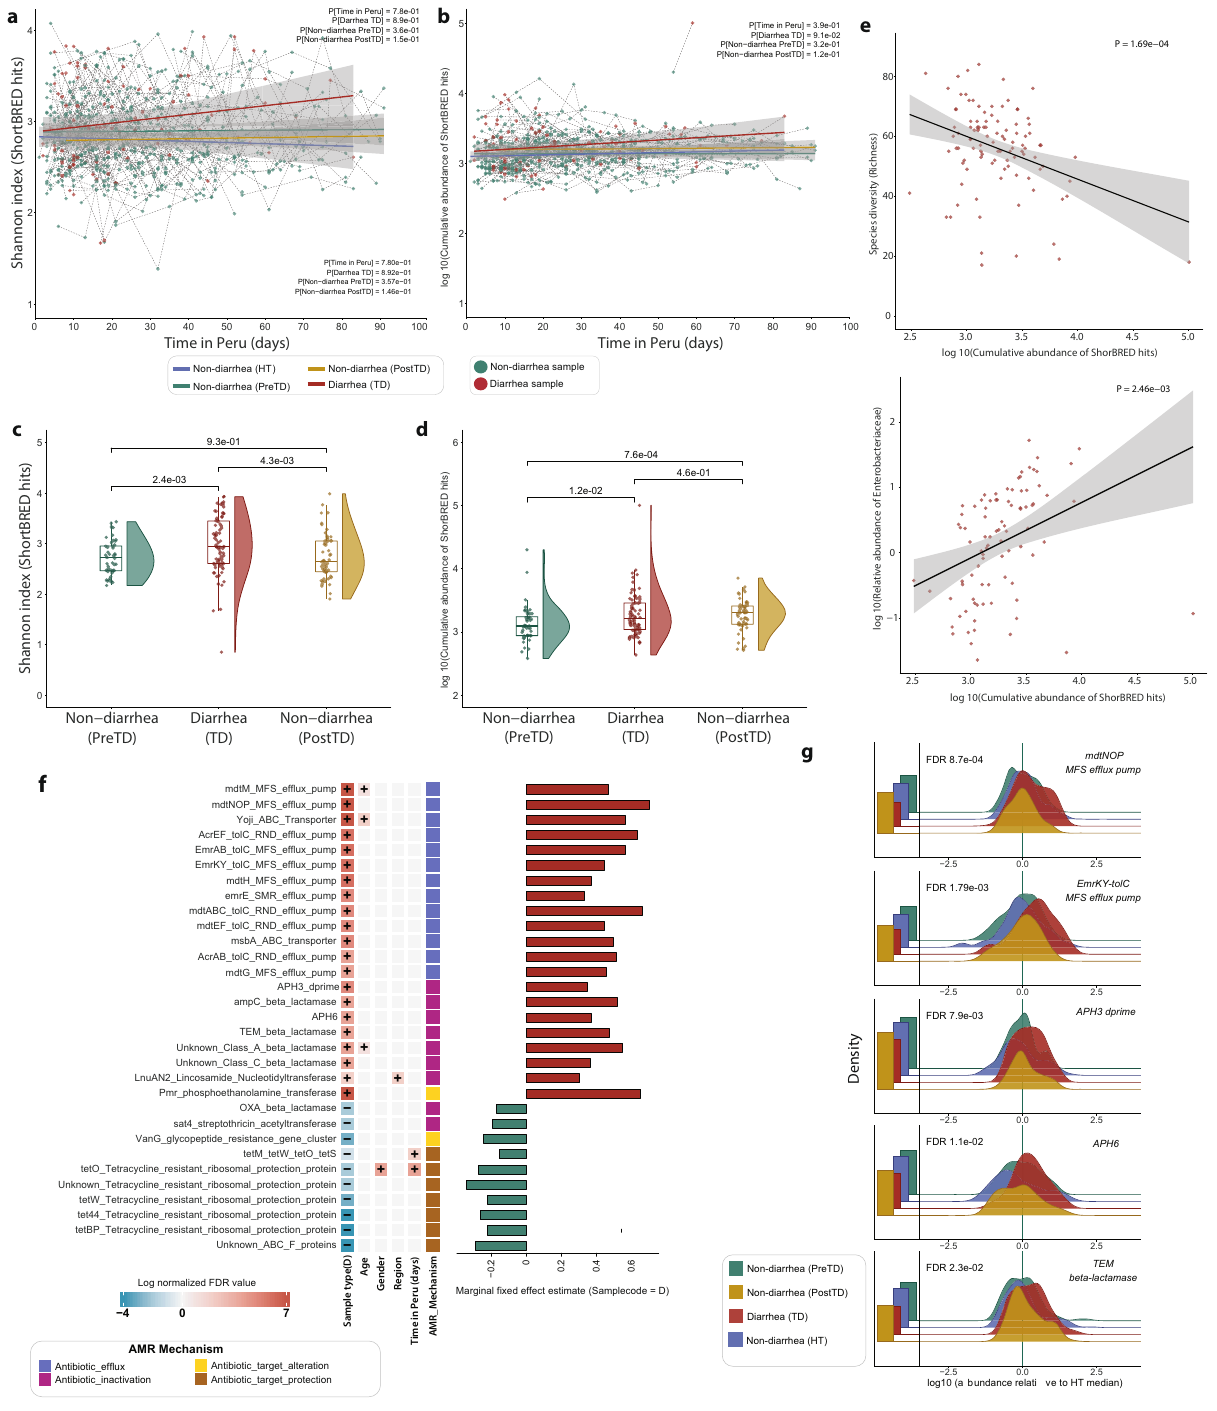
clusters were independently con fi rmed using BAPS 51 . Our DEC isolates P <0.05). These isolates were signi fi cantly enriched for bla TEM-148 , sul2 , grouped into 6 distinct clusters corresponding to phylogroups A, B1, B2, D, E, and F. The majority belonged to Clade A (106/189; 56.1%) and Clade B1 (56/189; 29.6%). No signi fi cant association between phy- logroups and sample type (diarrheal vs. non-diarrheal) was observed (Fishers exact test, P >0.05), except for isolates belonging to Clade B2 and Clade F that were isolated only from non-diarrheal samples. DEC strains isolated from non-diarrheal samples in TD subjects encoded more ARGs than isolates from HT subjects (Fig. 6a; Supple- mentaryFig. 7a,b) (non-diarrhealHT vs. non-diarrheal TD, Wilcox test,